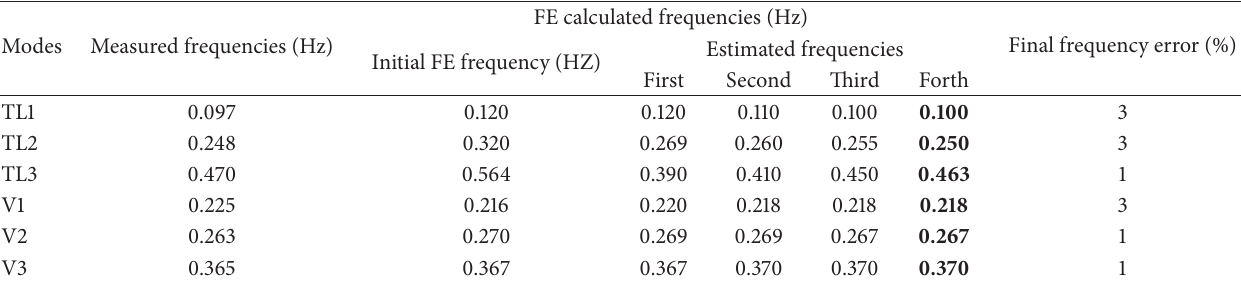
Table 7: Comparison between calculated FE and measured frequencies.